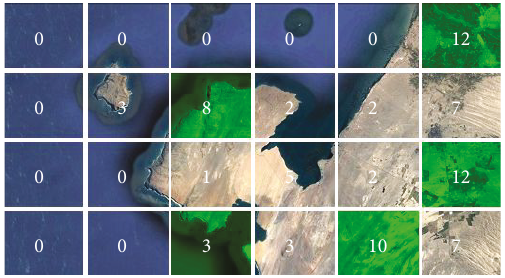
Figure 9: CSA result with automatic determined threshold T = 0 3333 .